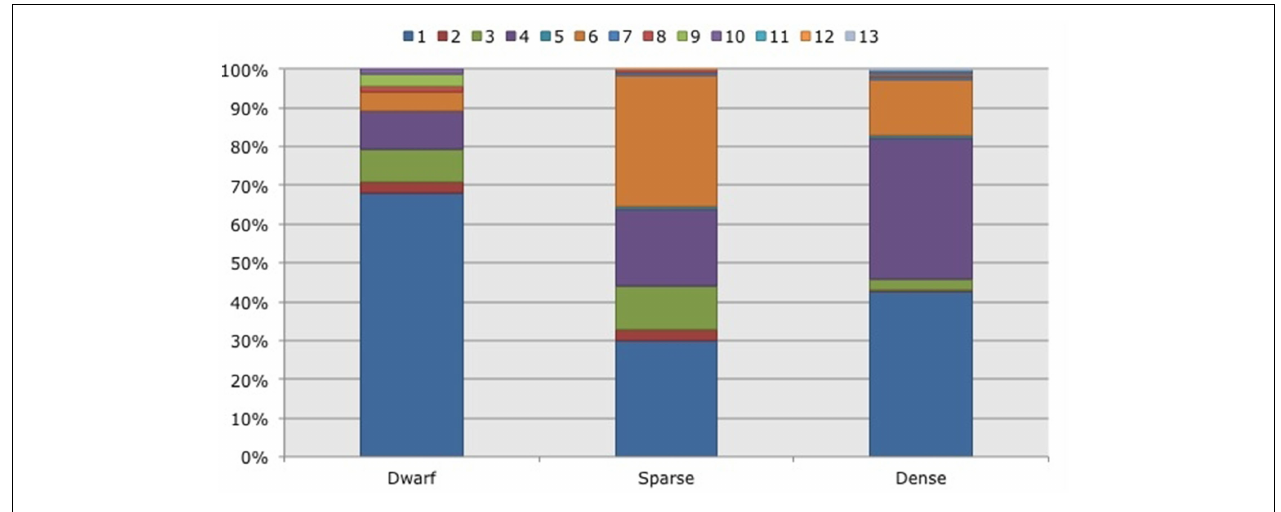
dense) dominated by Black mangroves ( Avicennia germinans ) in two impoundments in the Indian River Lagoon, Florida. Different colors indicate different